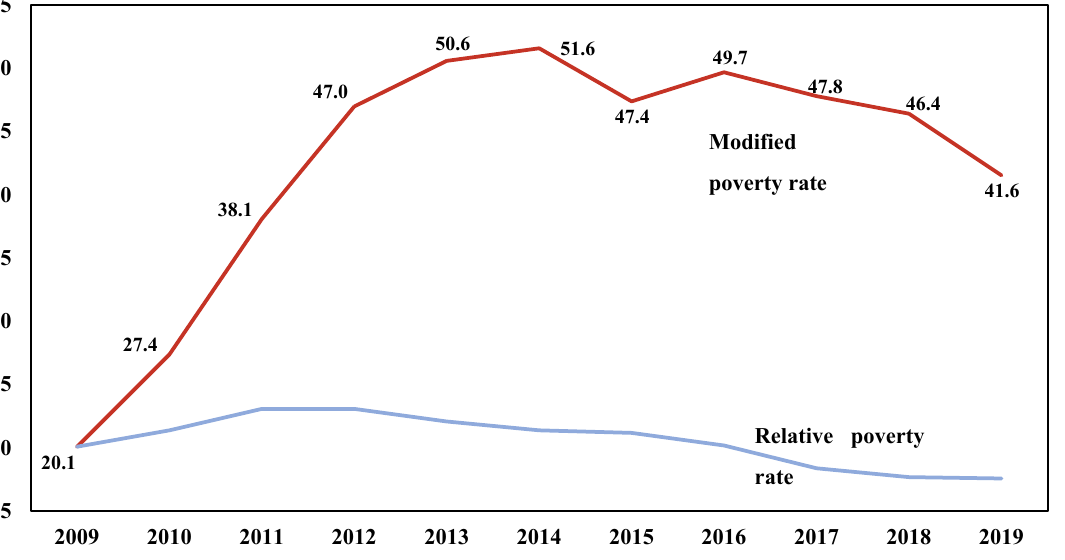
Figure 5. Relative Poverty Rate (percent) and Poverty Rate (percent) Fixed in Time and Deflated (2009 = 100), Greece, 2009–2019. Source: Hellenic Statistical Authority and authors’ own calculations.